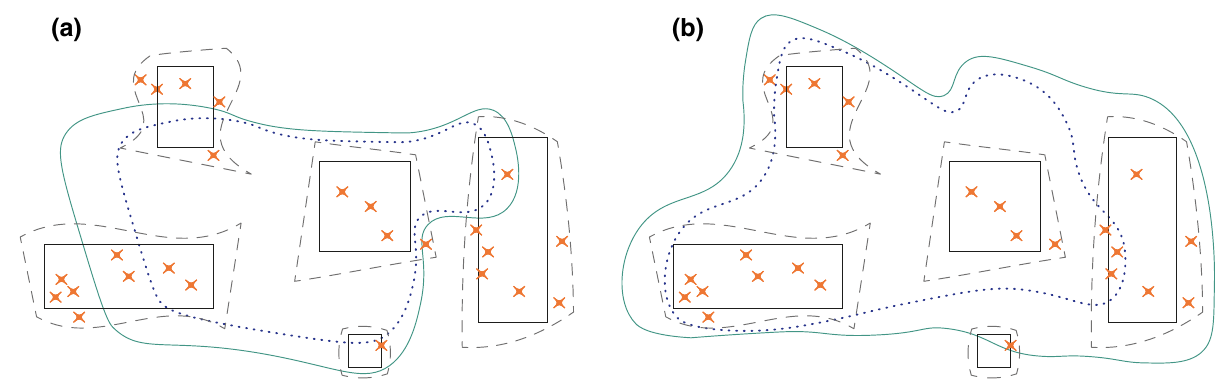
FIG. 5. Graphical representation of patches on a graph. To help the visualization we imagine the qubit graph and the syndrome graph to be superimposed. Black rectangles: connected components of the error E 1 , . . . , E 5 . Dashed grey lines: neighbour sets (cid:16)( E i ) of the underlying rectangle and error component. Orange crosses: syndrome nodes in σ( E i ) . Dotted blue curve: t patches on the qubit graph. Green curve: ω t patches on the syndrome graph. In (a) the patches are generic while in (b) the dotted and error patch is a canonical patch for the error. The importance of the canonical form for a patch is highlighted in the differences between the patches in (a),(b). We observe how the crosses and syndrome nodes σ( E i ) are scattered inside the dashed curve and neighbor set (cid:16)( E i ) . For this reason, in order to group enough syndrome nodes inside a patch of bounded size, we need some care in the choice of the error nodes. When we include entire connected components of the error in a patch in G q , we are able to build a patch in G s , which includes entire neighbor sets and, as a consequence, all the corresponding syndrome nodes. In fact, even if we assume that the dotted blue and error patches in (a),(b) have the same size, when we enlarge them by a factor of ω to build the green and syndrome patch, we obtain dramatically different results. In (a) since the dotted and error patch contains several incomplete components, the corresponding green and syndrome patch contains incomplete portions of the dashed and neighbor sets (cid:16)( E i ) . Hence, we have no guarantee on the number of crosses and syndrome nodes included in the patch. In (b) the dotted blue patch is a canonical patch for the error. We can see how the green and syndrome patch entirely contains the dashed and neighbor sets of all but one component of the error contained in the dotted blue and qubit patch. In this way we have the certainty to include in the green and syndrome patch a sufficient number of crosses and syndrome nodes to ensure